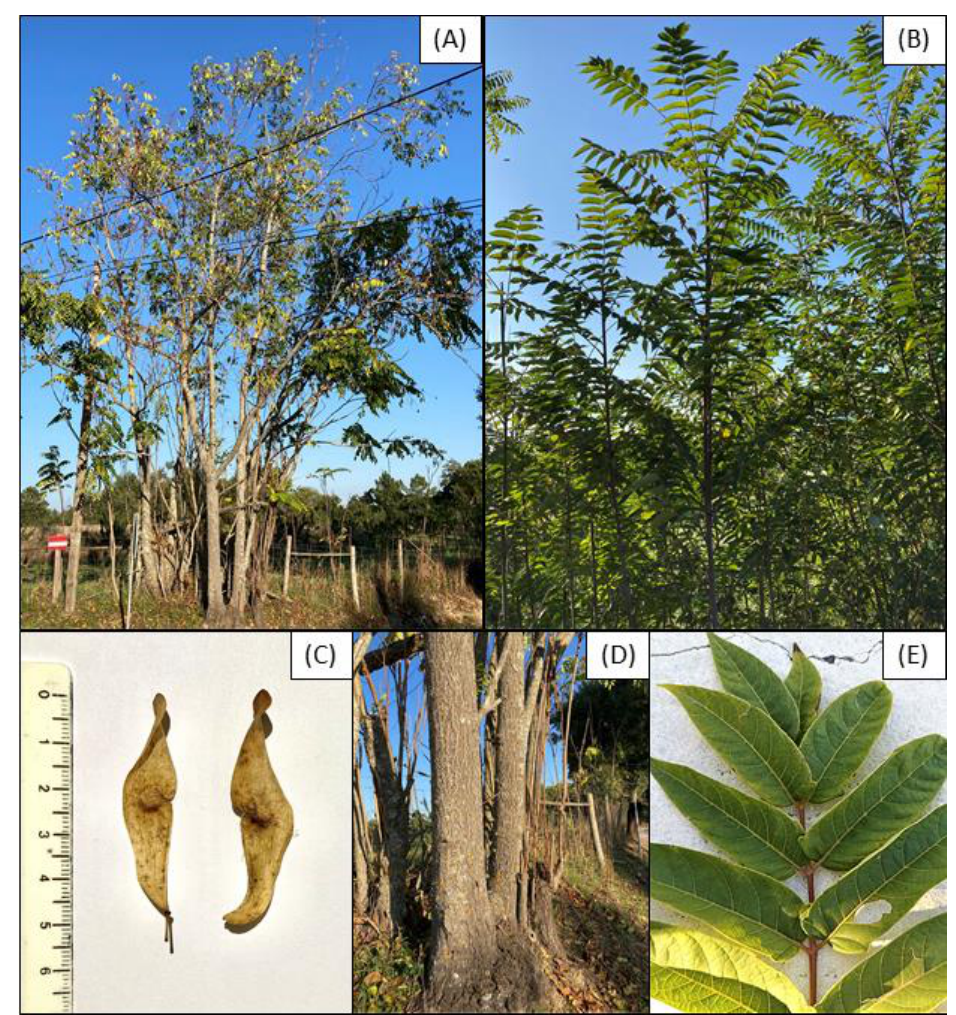
Figure 1. Some examples of A. altissima in the Castelo Branco region (Portugal); ( A ) an old plant; ( B ) a younger plant; ( C ) the samaras with seeds in the middle; ( D ) the trunk of the first plant and ( E ) part of a leaf with its leaflets.